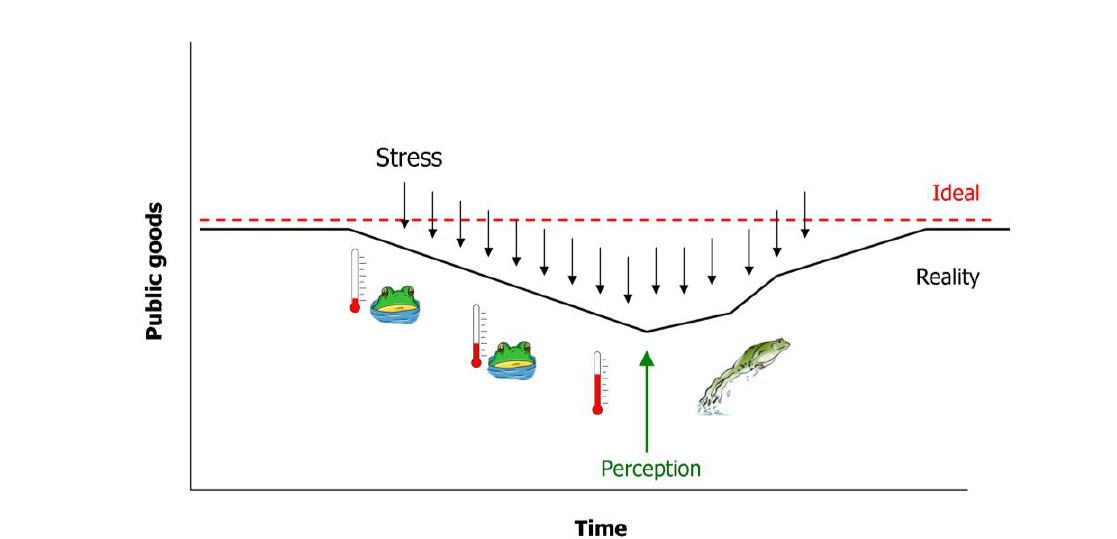
Figure 9. Perceived stresses and chances of